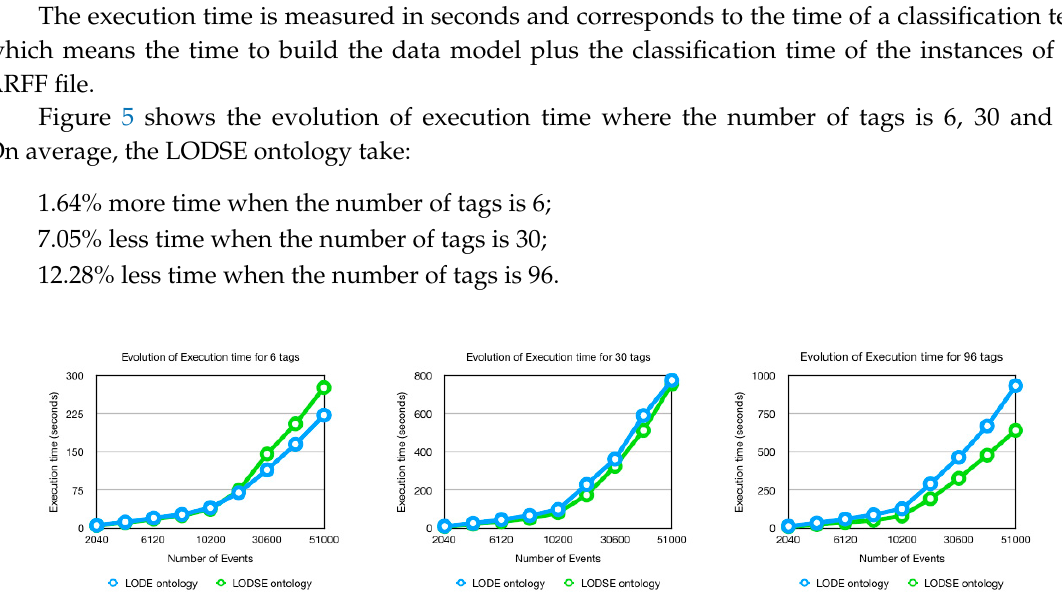
Figure 5. Evolution of execution time for 6, 30 and 96 Figure 4. Evolution of execution time for 6, 30 and 96 tags.